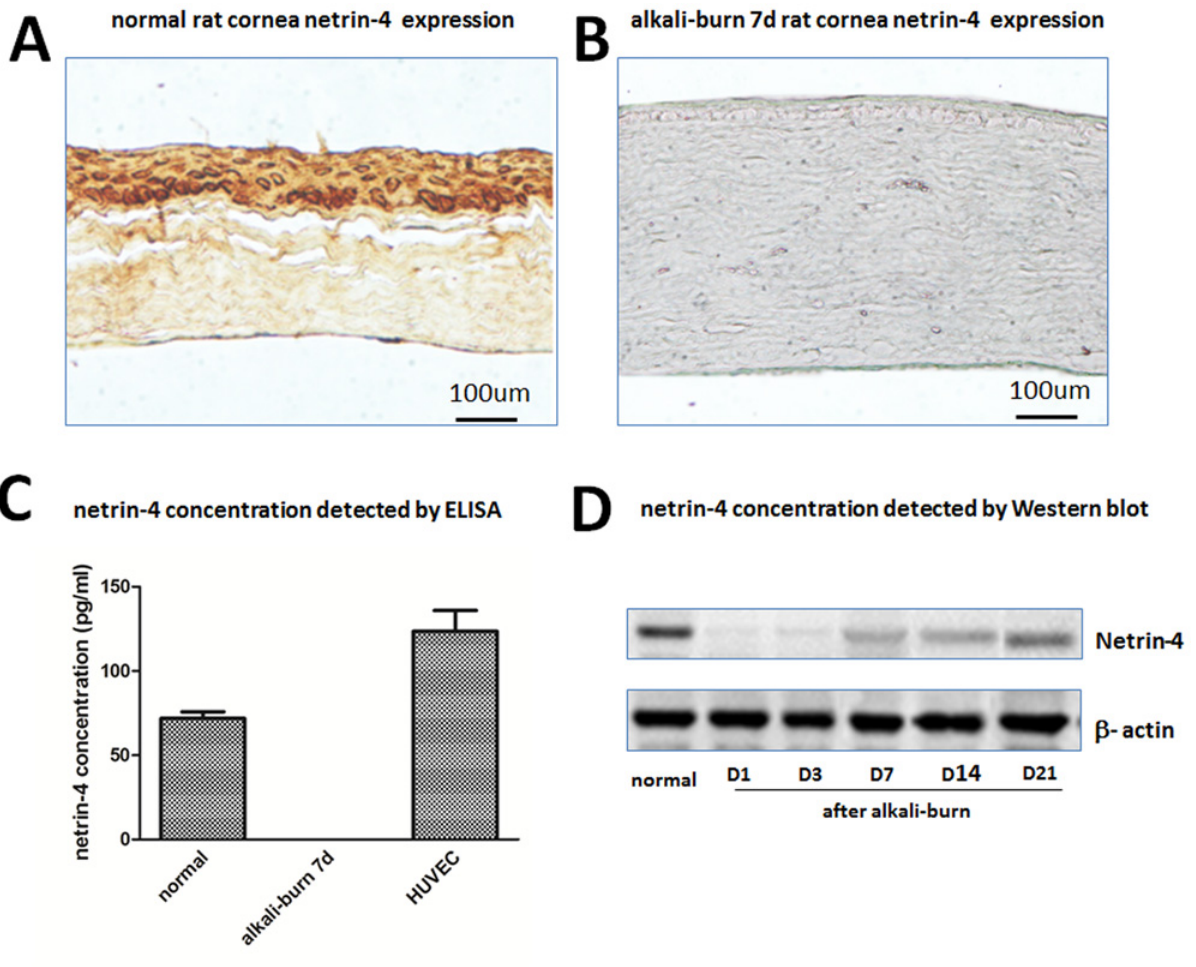
Fig 1. Levels of netrin-4 in endothelial cells, and in cornea before and after alkali-burn were detected by ELISA, IHC and Western blot. Netrin-4 expression in normal (A) and after alkali-burn rat cornea (B) by immunohistochemical staining. Netrin-4 concentrations in rat cornea and HUVEC (C). Netrin-4 concentration in normal rat cornea and different time after alkali-burn